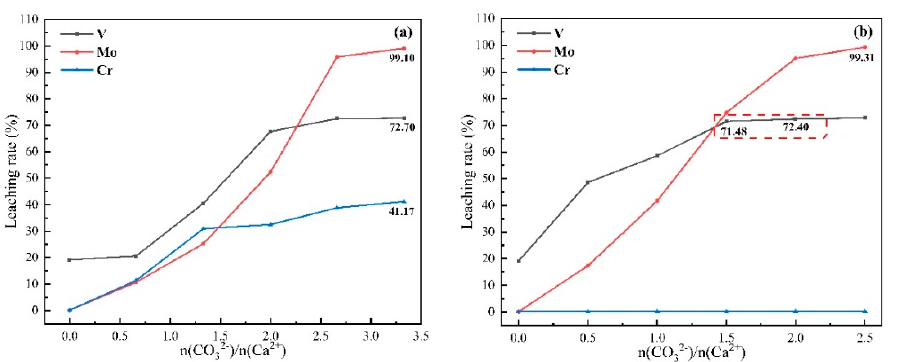
Figure 7. Effects of n(CO 3 2 − )/n(Ca 2+ ) on the leaching rates of V, Cr, and Mo. ( a ) Na 2 CO 3 system (600 °C); ( b ) K 2 CO 3 system (200 °C).